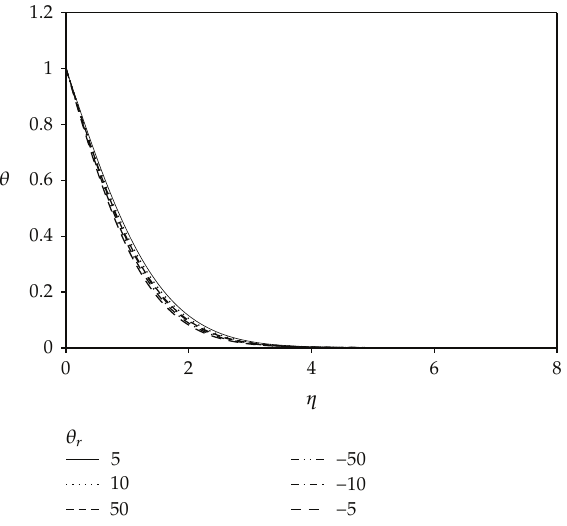
Figure 5: Temperature profile for di ff erent values of θ r for Du (cid:8) 0 . 03, Sr (cid:8) 2, N (cid:8) 1, Le (cid:8) 0 . 1, Pr (cid:8) 0 . 71, and Sc (cid:8) 0 .